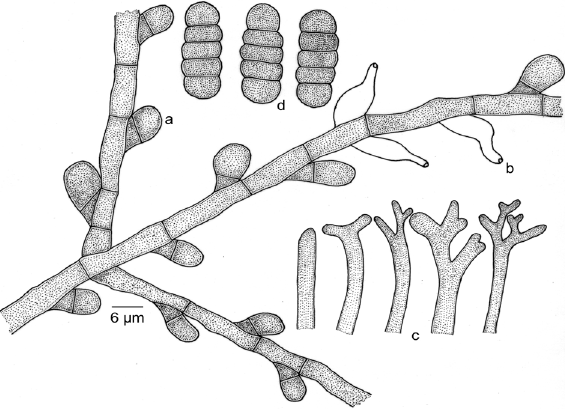
Figure 3. Meliola kamettiae sp. nov. a - Appressorium; b - Phialide; c - Apical portion of the